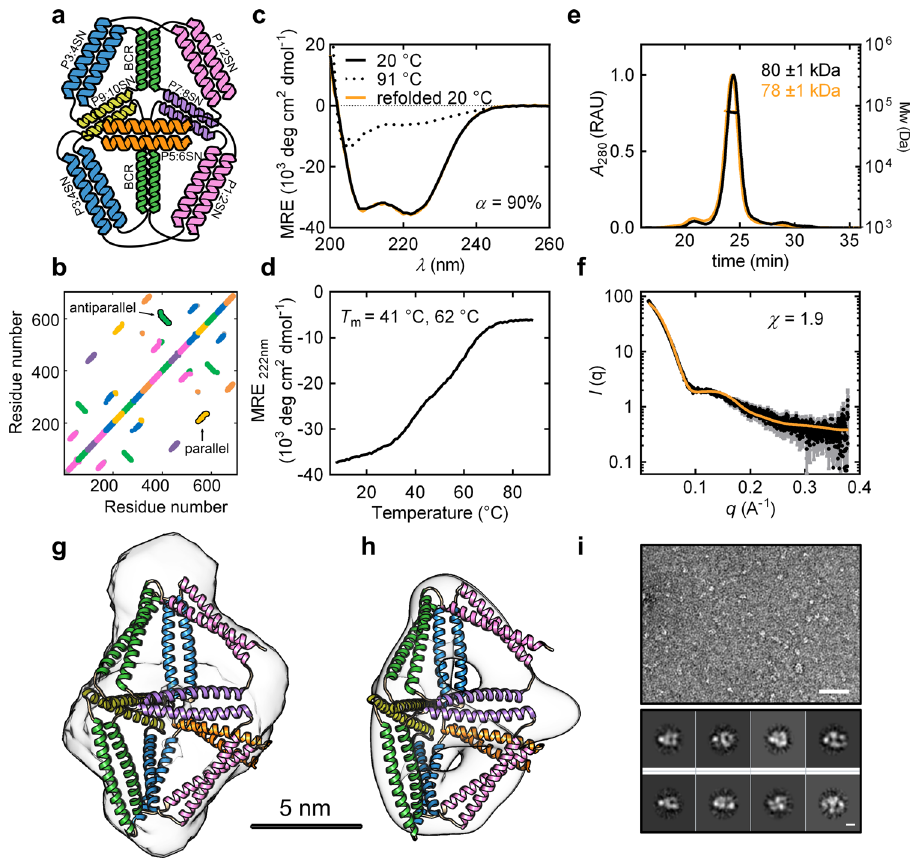
Fig. 1 Design and characterisation of the single-chain CCPO trigonal bipyramid cage BIP18SN. a Topological scheme of BIP18SN; CC pairs are represented as coloured helices. b Contact map of amino acids (8 Å distance cut-off) in the model of BIP18SN shown in g and h . Representative parallel and antiparallel CC dimers are indicated. c Circular dichroism (CD) spectra of the protein BIP18SN at 20 °C, 91 °C and 20 °C after refolding. d CD signal at 222 nm expressed in mean residue ellipticity (MRE) of the protein BIP18SN during thermal denaturation, the melting temperatures ( T m ) are indicated in the panel. e SEC-MALS chromatogram of BIP18SN before and after refolding (black and orange traces, respectively). UV signal is reported in relative absorbance units (RAU). The molecular weight of the main peak calculated from light scattering is indicated in the fi gure and corresponds to the theoretical mass calculated from the amino acid sequence (theoretical Mw of BIP18SN = 80.0 kDa). The data are representative of three independent repetitions of the experiment ( n = 3). f Experimental SAXS pro fi le of BIP18SN (black trace) and theoretical scattering calculated for the model structure shown in panel f (orange trace). Error bars in grey represent the standard deviation for each data point in black (mean). g SAXS ab initio reconstruction superimposed on the model exhibiting the best fi t to the experimental SAXS data ( χ = 1.9). The bar indicates a distance of 5 nm. h Electron density calculated from the single-particle reconstruction of negative-stain TEM images overlaid with the model exhibiting the best fi t to the experimental SAXS data. i Above, representative section of 150 negative-stain TEM micrographs of BIP18SN (scale bar = 50 nm). Below, reference-free two-dimensional (2D) class averages from negative-stain TEM micrographs of BIP18SN (scale bar = 5 nm). Source data are provided as a Source Data